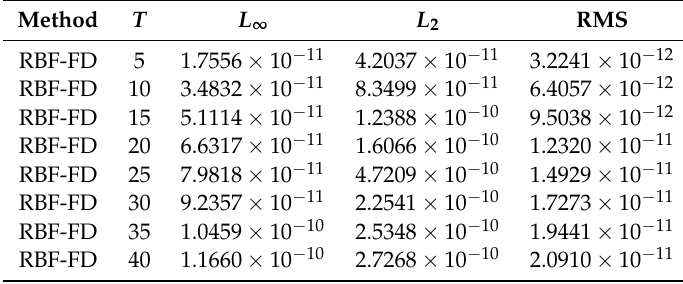
Table 1. The L ∞ , L 2 and RMS errors with τ = 0.01, N = 100, n i = 589 and c = 1.8 for Example 1.